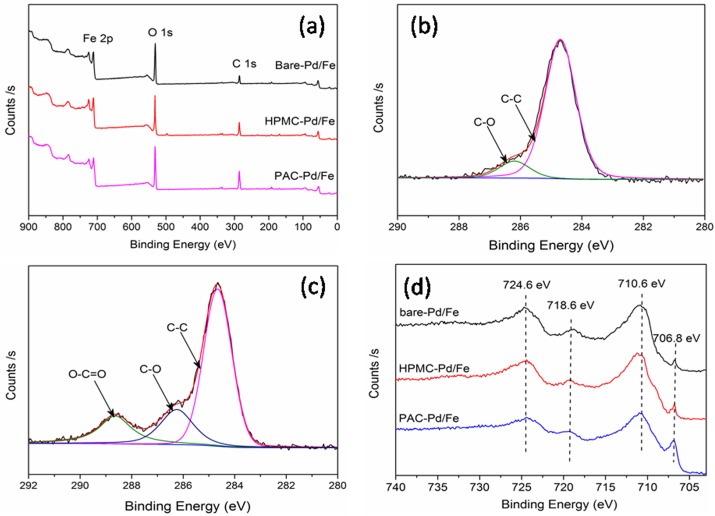
XPS images of bare and cellulose-modified Pd/Fe NPs: (a) full-range XPS spectra, (b) C1s of bare-Pd/Fe NPs, (c) C1s of PAC-Pd/Fe NPs, (d) Fe 2p spectra. Fe loading is 0.4 g L-1 with Pd 0.3 wt% of Fe, cellulose is 1 g L-1.